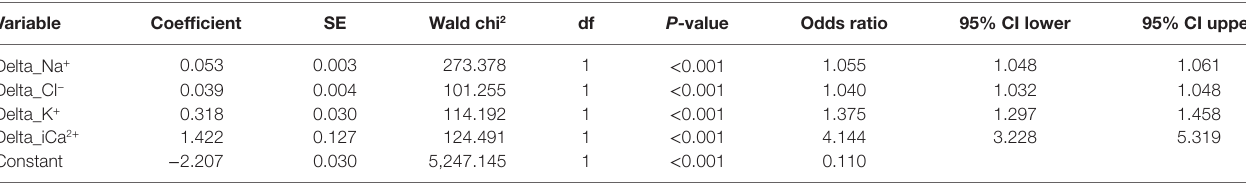
Table 3 | Final multivariable